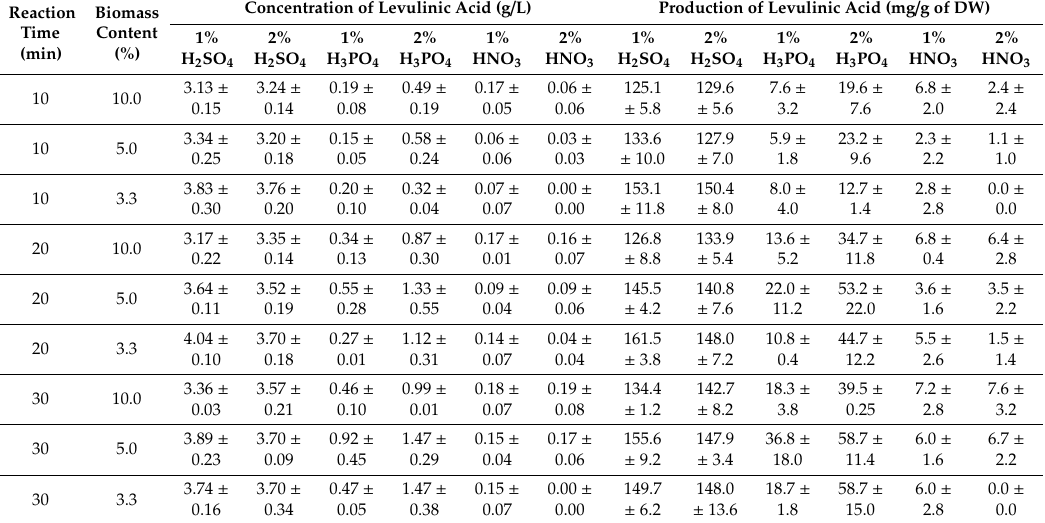
Table 3. Influence of reaction time, biomass content, concentration and type of inorganic acid on microwave-assisted production of levulinic acid from sweet cherry chips. Reaction Time